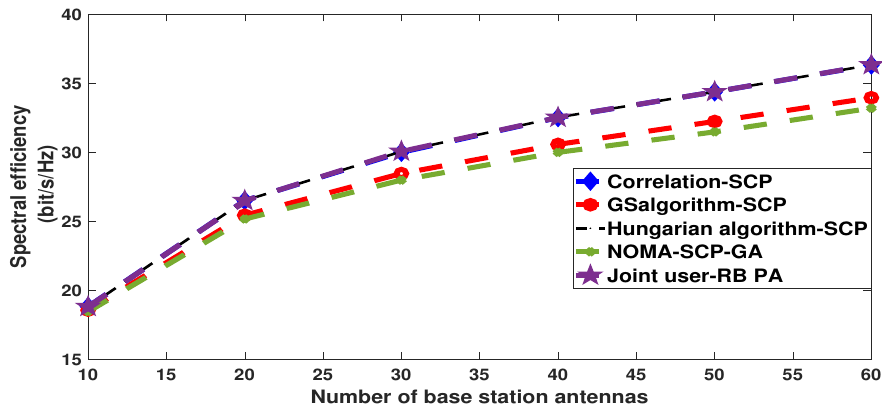
Figure 5. The spectral efficiency versus number of BS antennas, with U = 10 users, ZF beamforming.